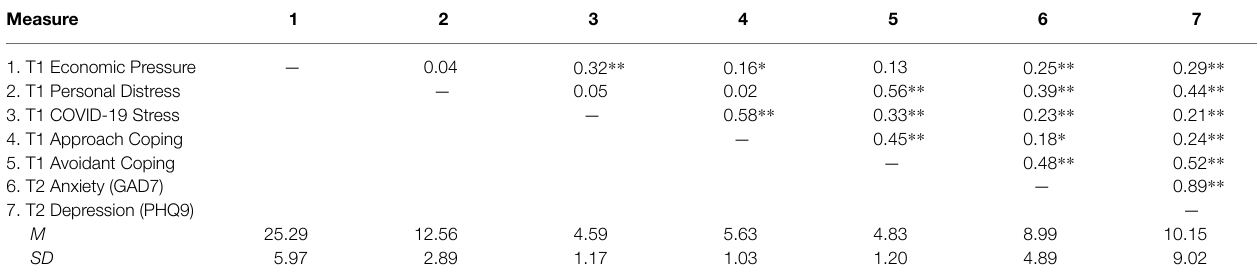
TABLE 2 | Bivariate correlations and descriptive statistics of covariates and variables of interest.